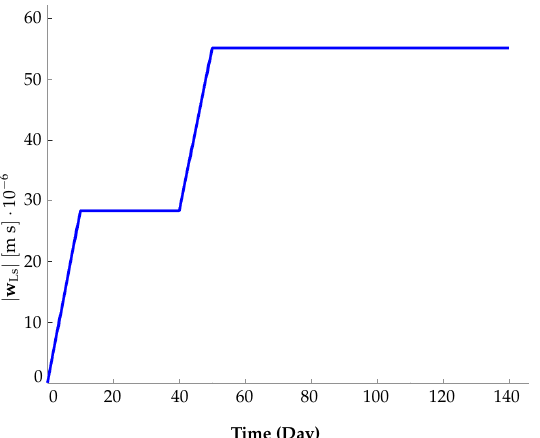
Figure 4. Theoretical progression of the | w LS | over time in the right corner of the vadose zone.